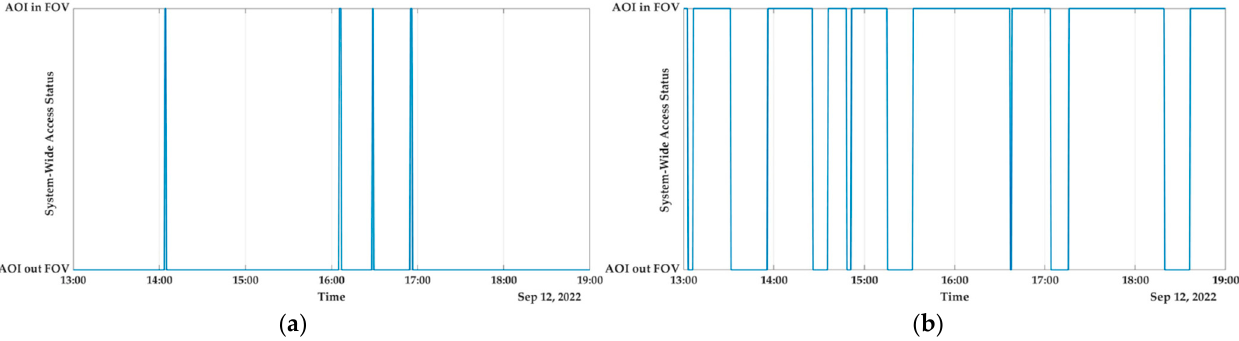
Figure 11. Africa: ( a ) system-wide access status; ( b ) system-wide access status with reconfiguration.